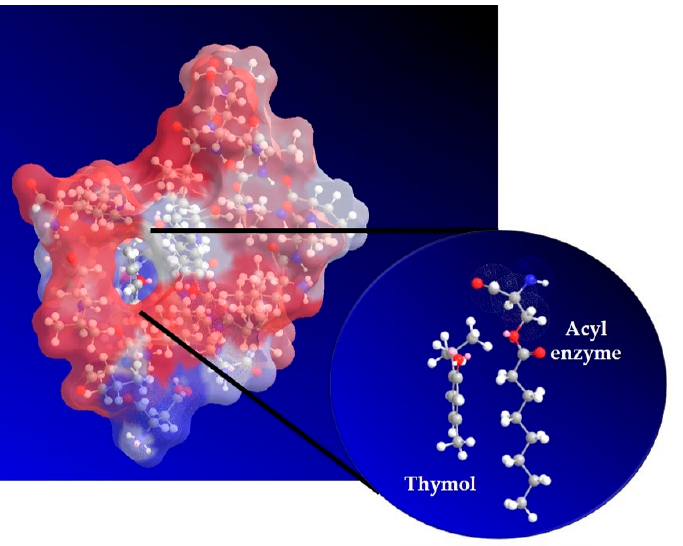
Figure 2. Reduced model of CALB with thymol in the vicinity of the acyl enzyme.